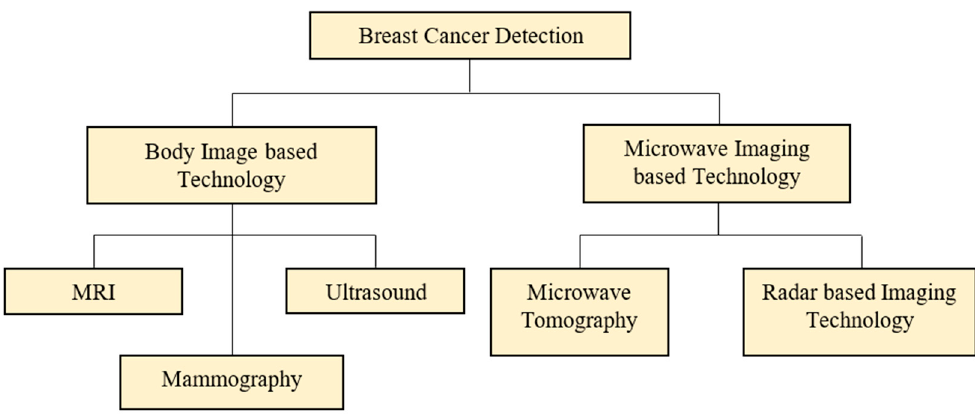
Figure 1. Breast cancer screening technology [18].